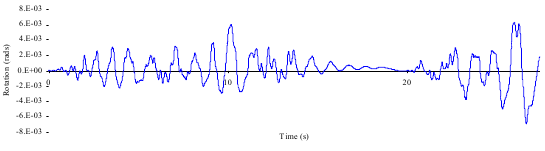
Figure 11. Rotations imposed at the top of the column.